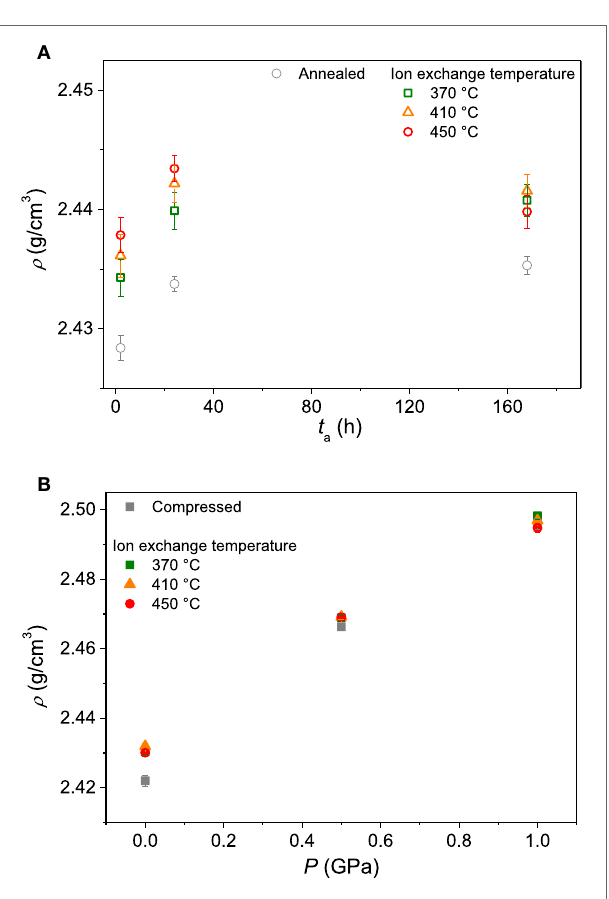
FigUre 3 | Density ( ρ ) of the glasses before ion exchange (gray symbols) and after ion exchange (colored symbols) treatment at three different temperatures (370, 410, and 450°c) . (a) Samples annealed at different durations ( t a ) at 0.92 T g . (B) Samples isostatically compressed at different applied pressures ( P ) at T g .